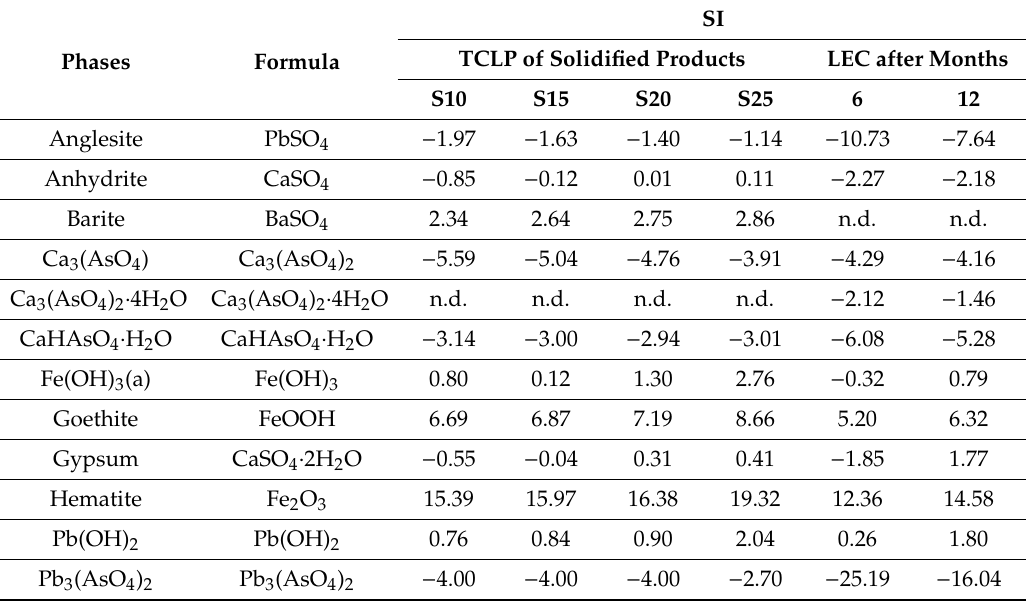
Table 8. SI’s of selected solubility-controlling phases under TCLP and LEC tests.